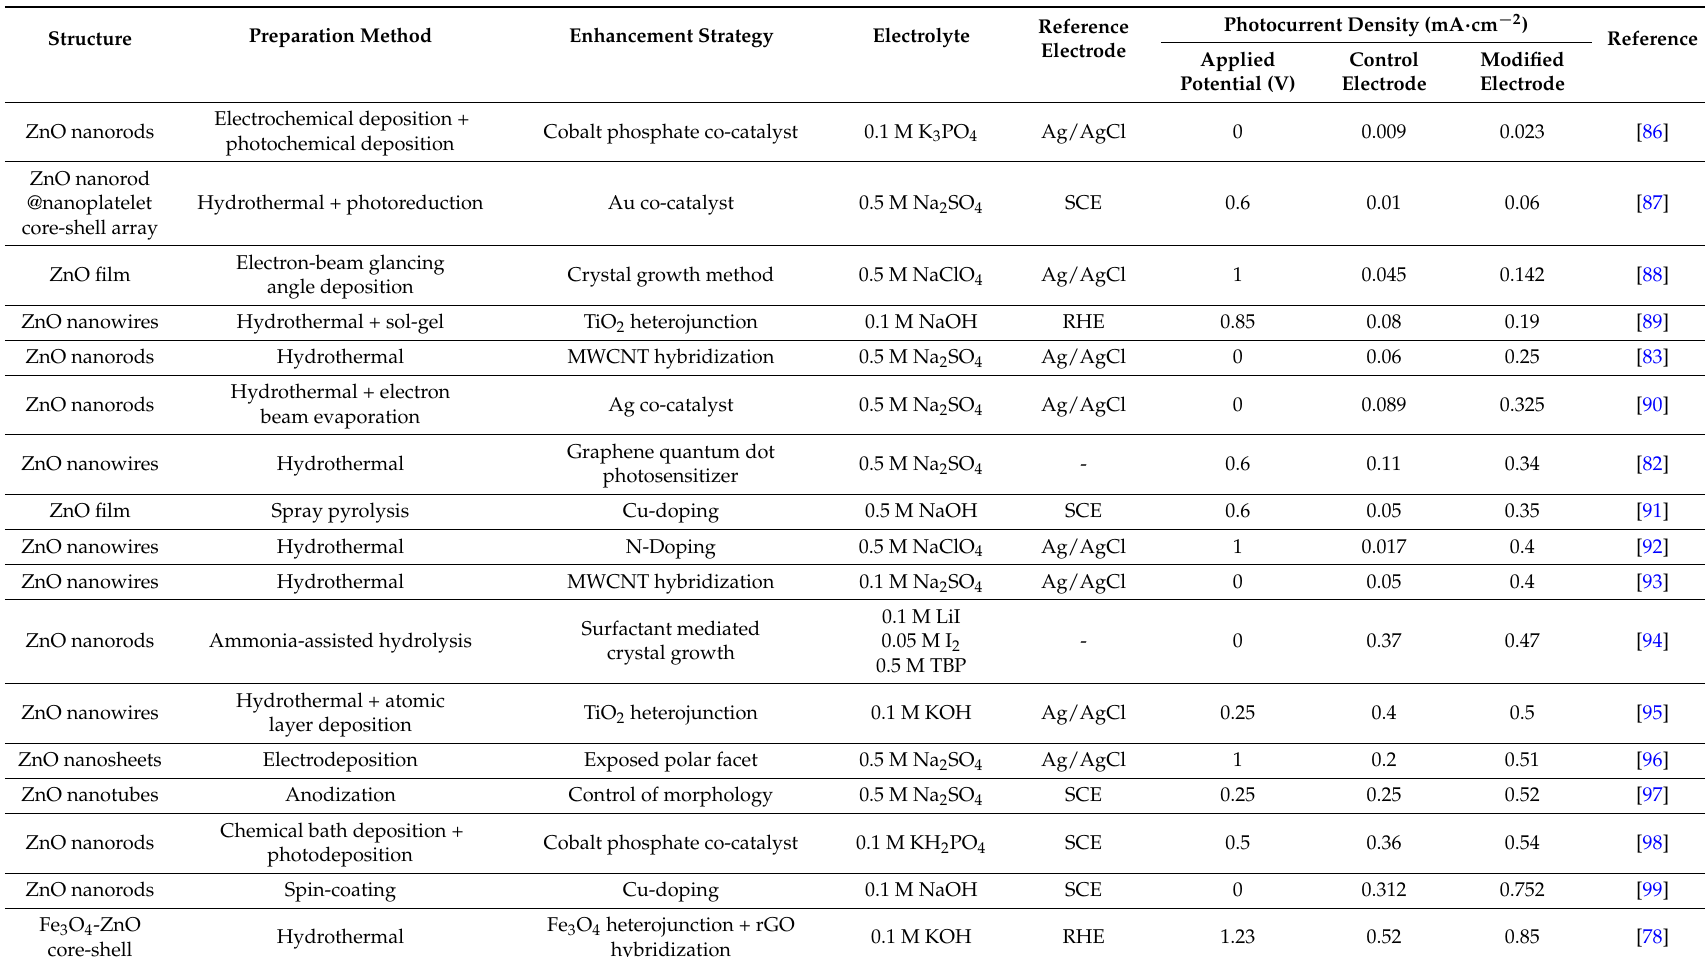
Table 2. Summary of modification strategies to enhance ZnO photocurrent density. SCE, Saturated Calomel Electrode; RHE, Reversible Hydrogen Electrode; MWCNT, Multi-Walled Carbon